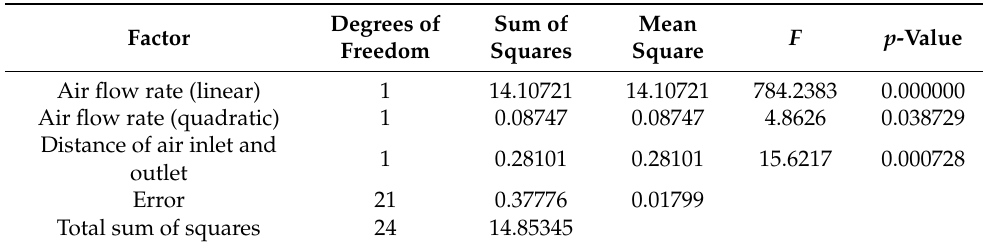
Table 10. Results of the analysis of variance applied to the internal pressure in the reaction cell with lateral air inlet and outlet geometry.